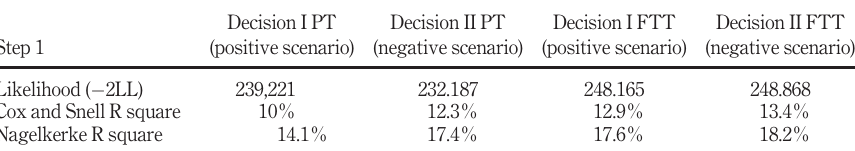
Table 8. Adjustment to the model